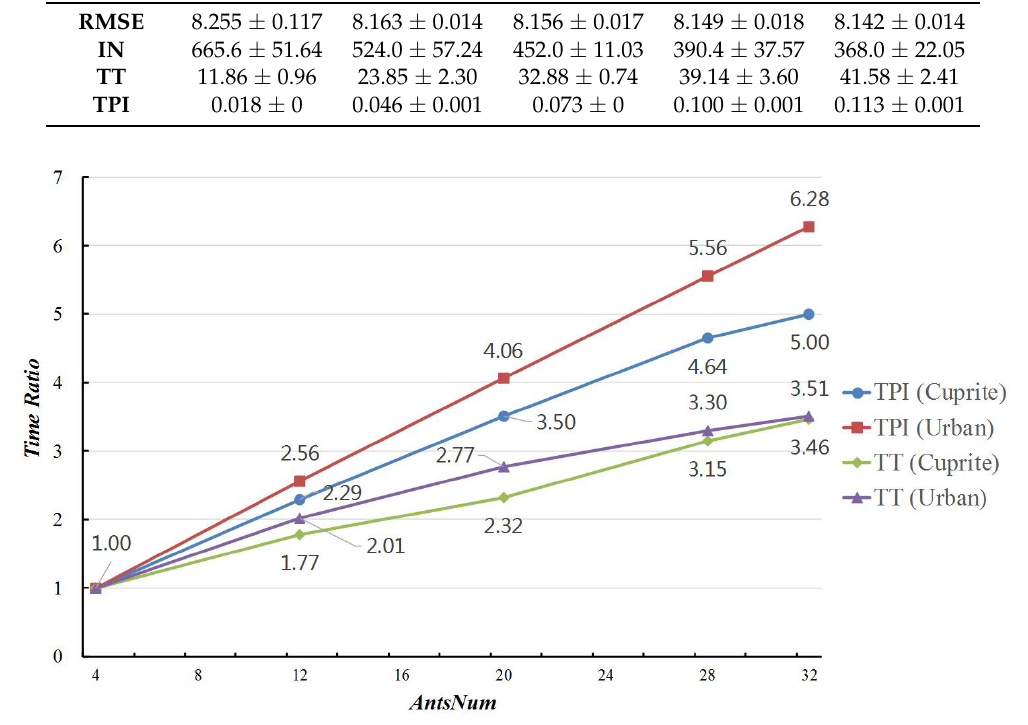
Figure 6. Time ratios of MG-ACOEE with different AntsNum and G-ACOEE.